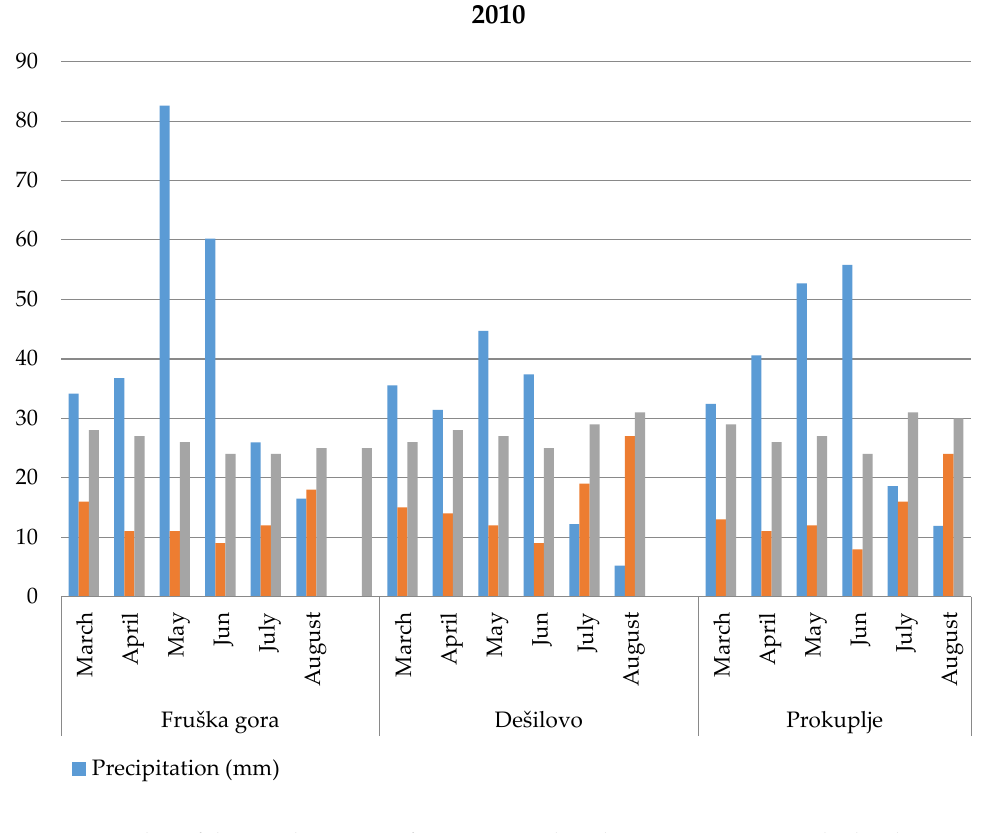
Figure 3. Variations of precipitation, number of extremely dry days, and duration of the dry period for selected regions during the March–August period of 2010.